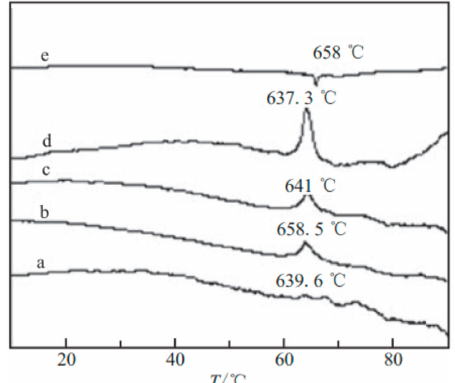
Figure 10. DSC of Al / B / Fe 2 O 3 nano-sized composites. Reproduced from [48], with permission from Gu Ti Huo Jian Ji Shu,